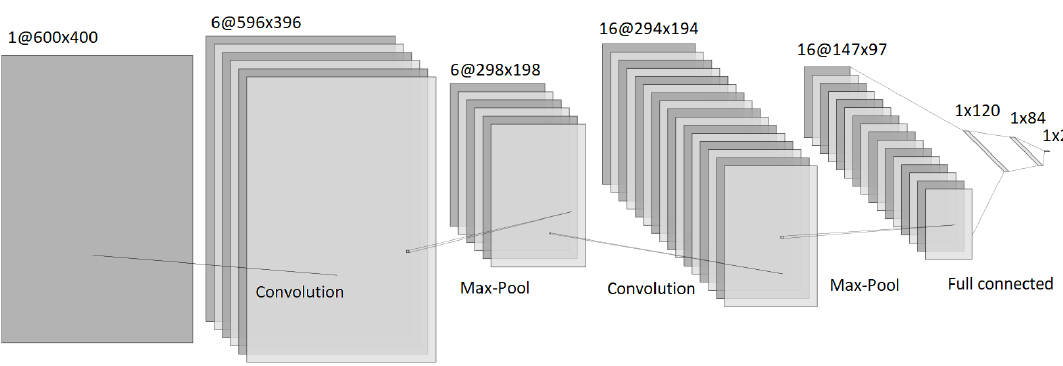
Figure 5. Architecture of the convolutional neural network (LeNet)—a tool used to build the diagram: